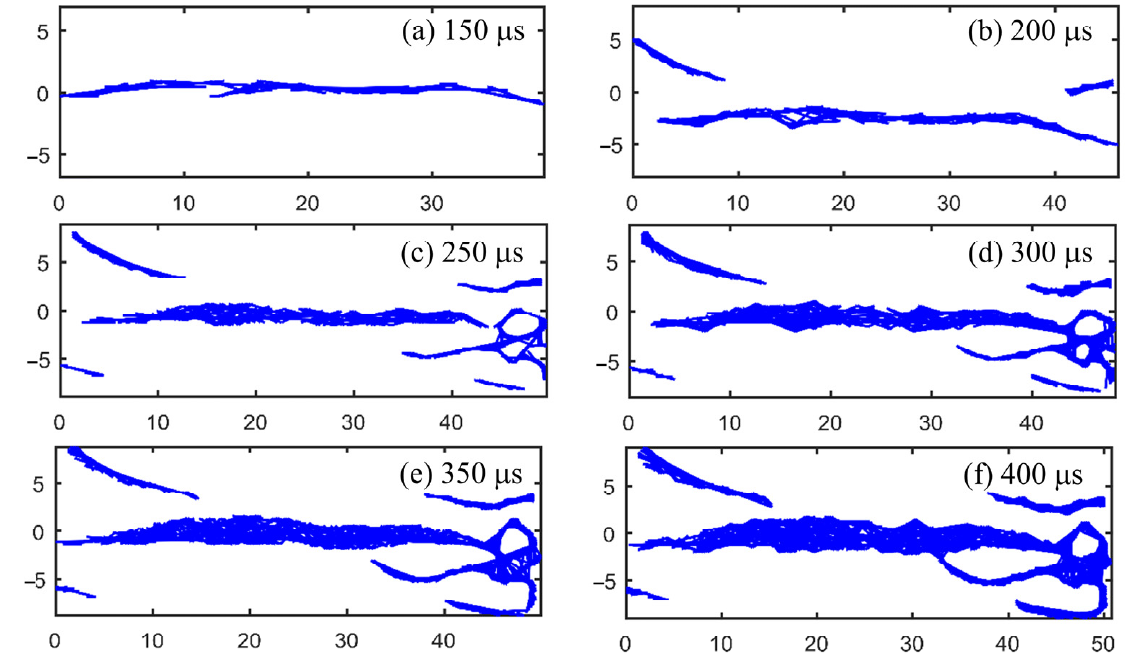
Figure 9. The fracture traces of the Breccia specimen at 4.86 m/s striking velocity obtained by FracPaQ: ( a ) 150 μ s; ( b ) 200 μ s; ( c ) 250 μ s; ( d ) 300 μ s; ( e ) 350 μ s; ( f ) 400 μ s.